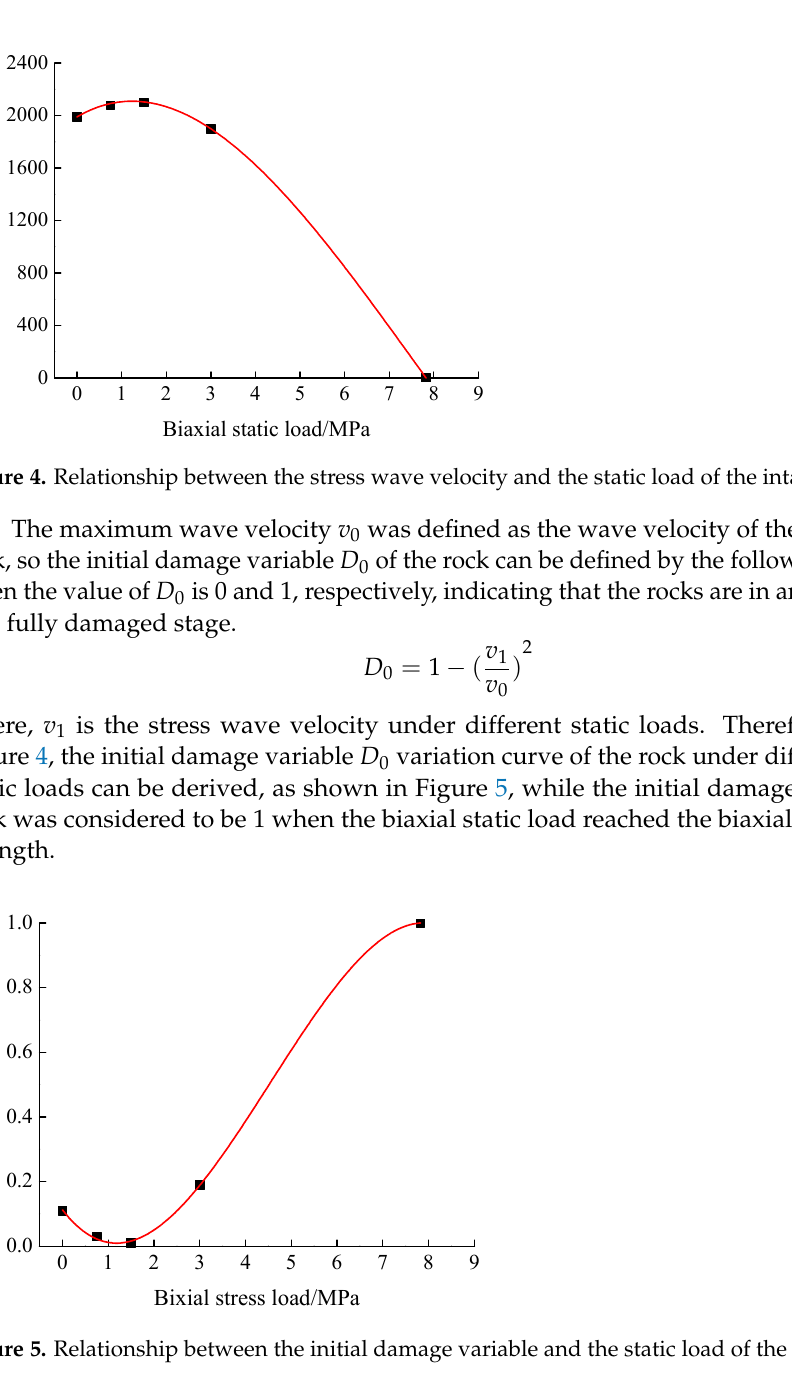
Figure 5. Relationship between the initial damage variable and the static load of the intact rock. fractures, the initial damage evolution within the rocks can be assumed to be